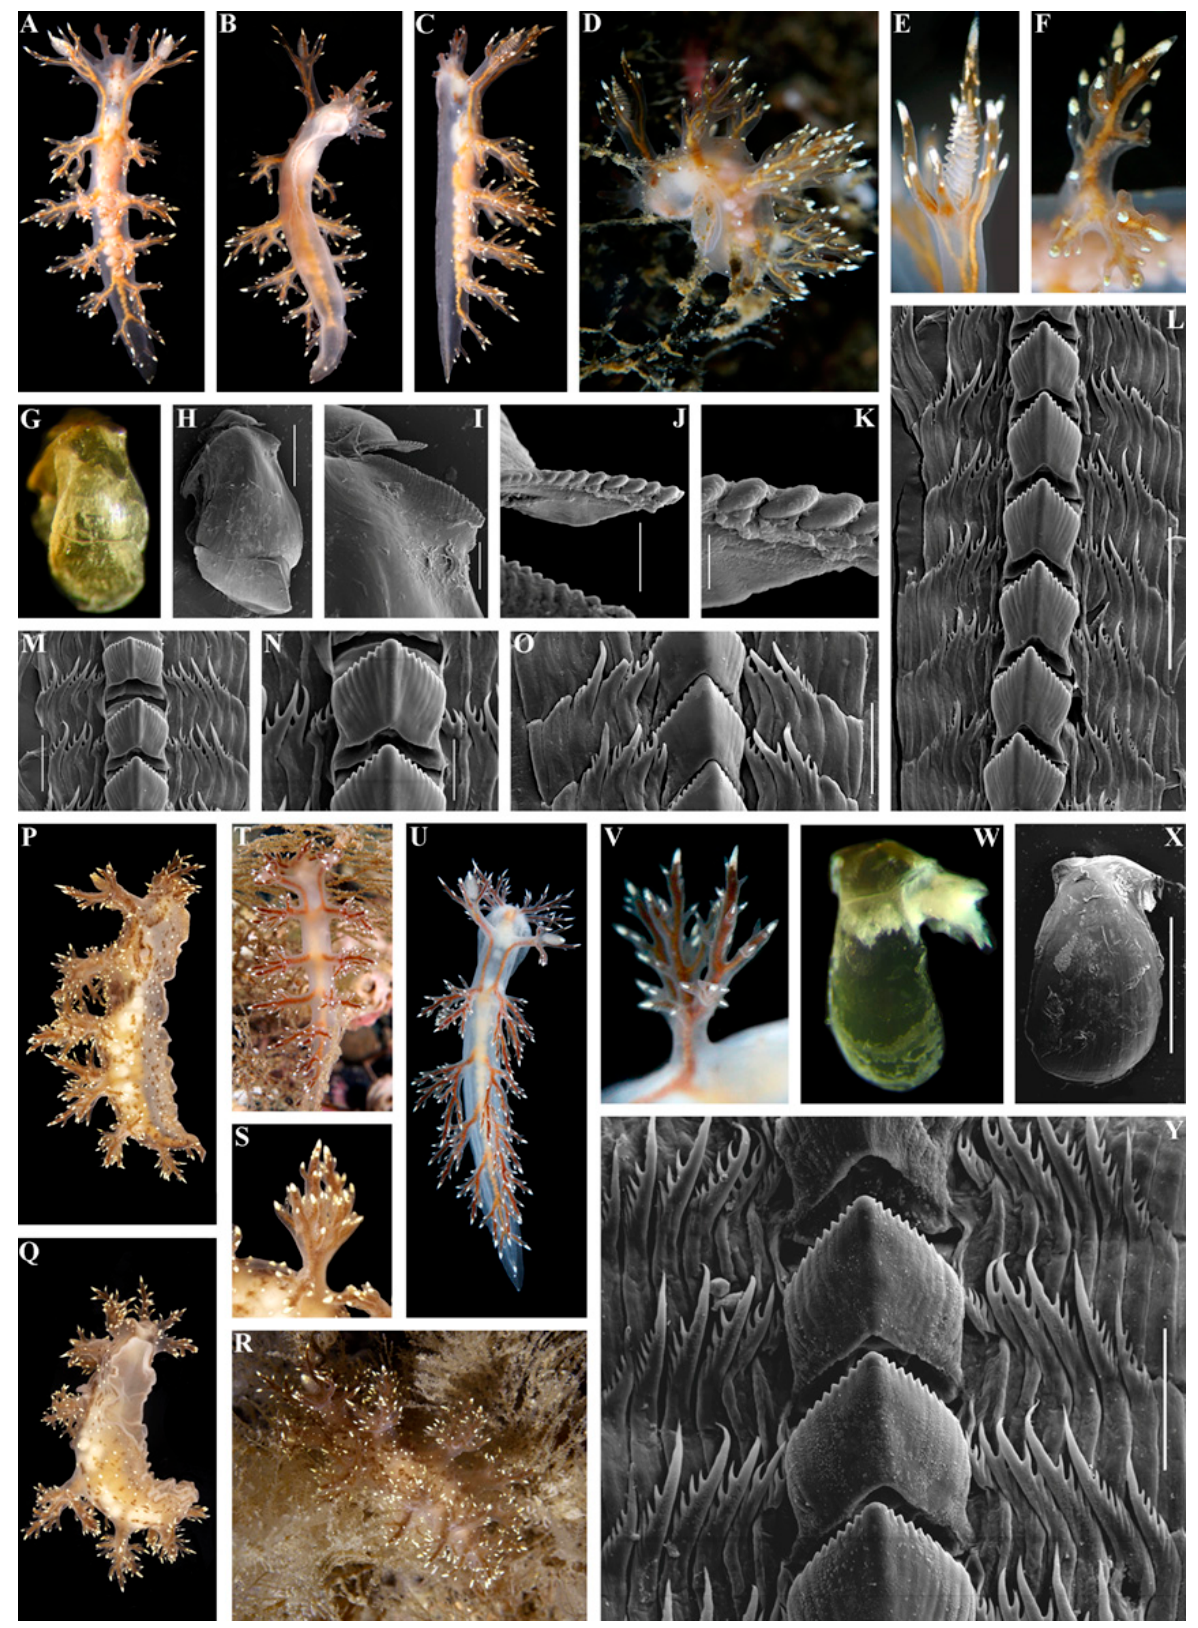
Figure 1. Dendronotus keatleyae n. sp. ( A – L ) Holotype, TNU-VM-82155, Norway: ( A ) dorsal view; ( B ) ventral view; ( C ) lateral view; ( D ) in situ; ( E ) rhinophore; ( F ) dorsolateral appendages, details; ( G ) jaw, light microscopy; ( H ) jaw, SEM, scale bar 500 µm; ( I ) denticles on the masticatory edge, SEM, scale bar 30 µm; ( J ) discoid structures on the masticatory edge, SEM, scale bar 30 µm; ( K ) details of discoid structures on the masticatory edge, SEM, scale bar 10 µm; ( L ) radula, posterior part, SEM, scale bar 100 µm; ( M ) radula, posterior part, details, SEM, scale bar 50 µm; ( N ) radula, posterior part, details, SEM, scale bar 30 µm; ( O ) radula, anterior part, SEM, scale bar 40 µm; ( P ) Paratype, CCMMO067-21, the United Kingdom, lateral view of a living specimen; ( Q ) the same, latero-ventral view; ( R ) the same, living specimen in situ. ( S ) the same, dorsolateral appendages, details; ( T – Y ) Paratype, NTNU-VM-82154, Norway: ( T ) living specimen in situ; ( U ) living speci- men, dorsal view; ( V ) the same, dorsolateral appendages, details; ( W ) jaw, light microscopy; ( X ) jaw, SEM, scale bar 1 mm; ( Y ) radula, posterior part, details, SEM, 50 scale bar µm. Photographs of living animals by Viktor V. Grøtan and Bernard Picton. SEM micrographs and light microscopy images by Alexander Martynov. Description Body elongate, living specimens (Figure 1) up to 35 mm in length when live. Holo- type 25 mm when live. Oral veil with 5 ‒ 6 main appendages, all branched. Up to 6 ap- pendages on rhinophoral stalks. Rhinophores with 11–14 lamellae; rhinophoral sheath with a lateral papilla. Adult with 7 pairs of dorsolateral appendages (including one ru- dimentary appendage posteriorly); each appendage with elongate primary stalk, mod- erately branched elongate secondary branches and short tertiary branches (Figure 1A–D,P). Basal colour semi-translucent white to pale greyish-brown; some specimens almost without any additional spots or lines (only very rare small white spots) or with